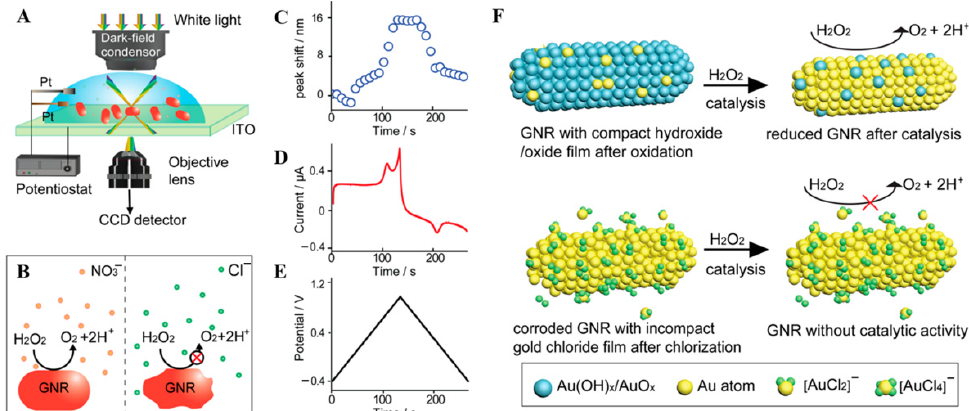
Figure 7. ( A ) Setup of dark-field microscopy integrated with an electrochemical workstation. ( B ) Electrocatalytic oxidation of H 2 O 2 on the surface of Au NRs in KNO 3 and KCl solutions, respectively. ( C – E ): Simultaneous plasmonic scattering spectra peak shift of single NR ( C ) and electrochemical current of entire samples ( D ) under the applied triangular wave potential ( E ) on the Au NRs. ( F ) Au NR with hydroxide/oxide film was partially reduced into Au atom, and H 2 O 2 was oxidized into O 2 after treatment of H 2 O 2 in KNO 3 solution (up). Au NR was corroded by the formation of [AuCl x ] − , and gold chloride blocked the catalytic activity of Au NR for oxidation of H 2 O 2 in KCl solution. Reprinted with permission from [60]. Copyright 2014 American Chemical Society.